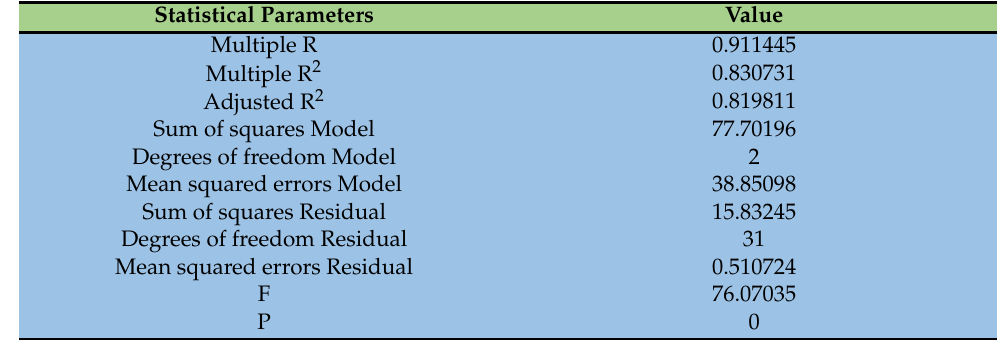
Table 2. Results of the relevant statistical parameters obtained from the Nano-QSTR regression model for